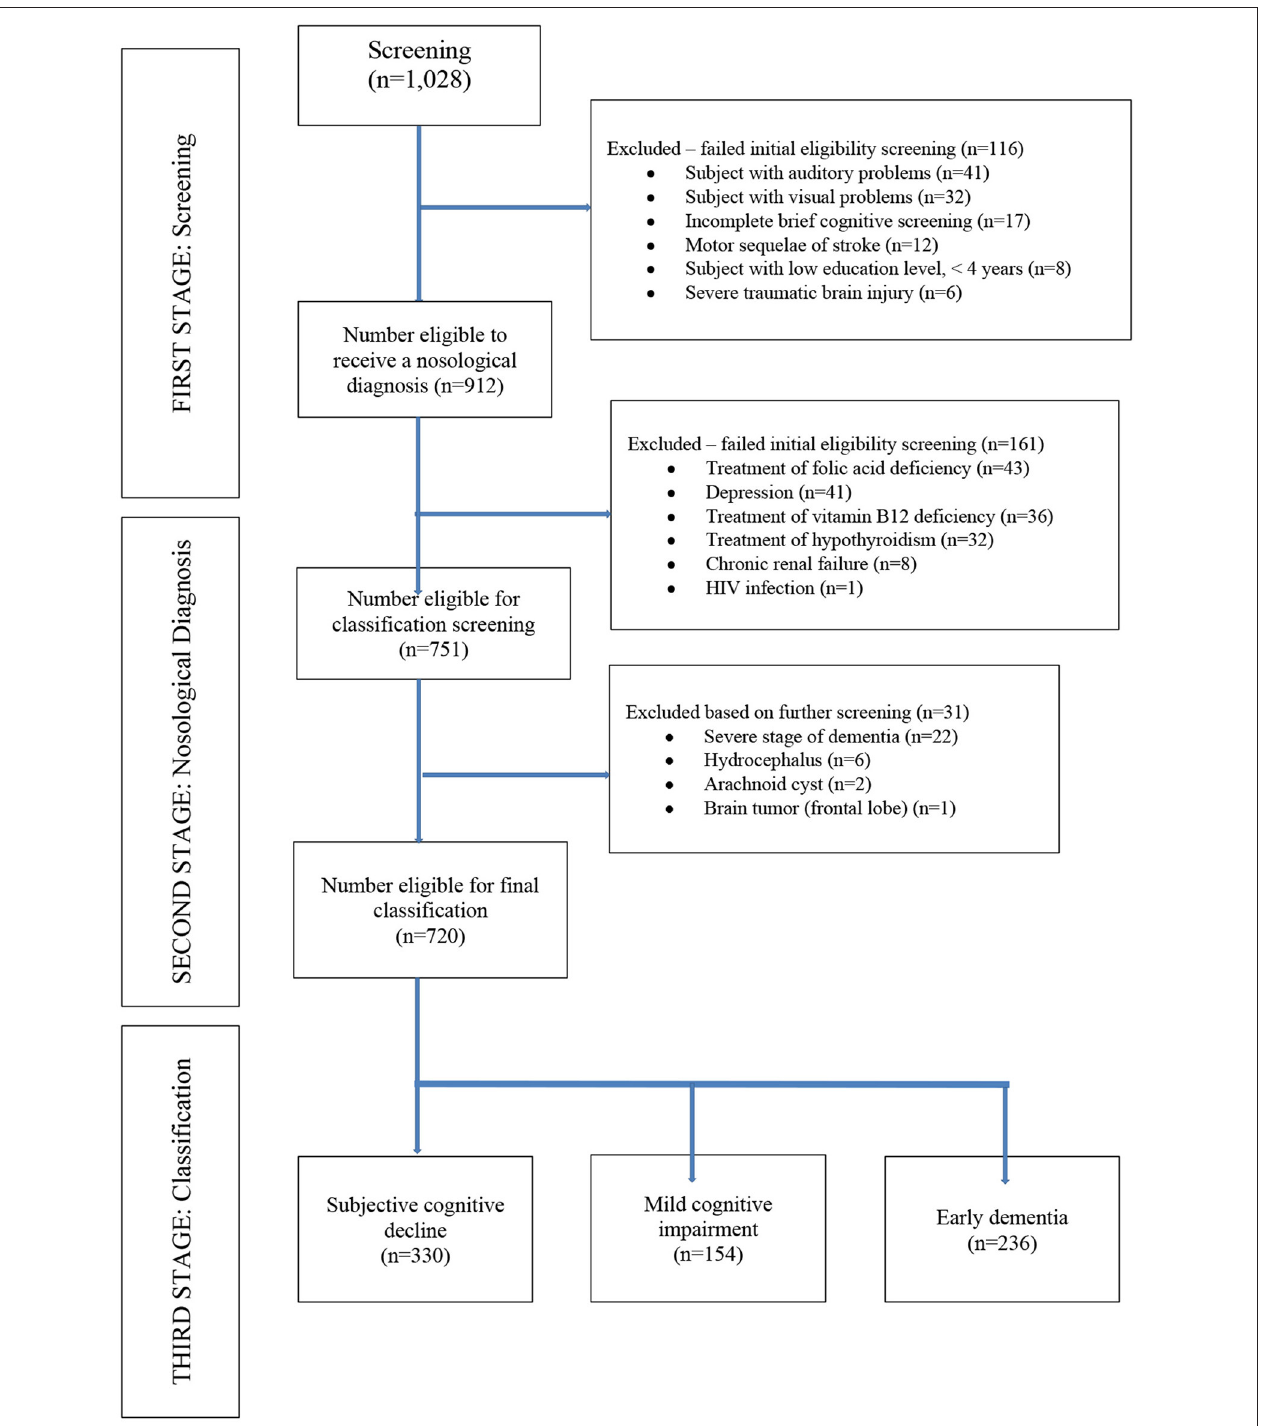
FIGURE 1 | Flowchart of participants included in the study by study phase ( N = 720).